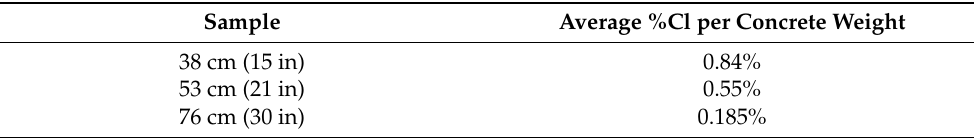
Table 7. Percentage of chlorite content per weight of concrete.